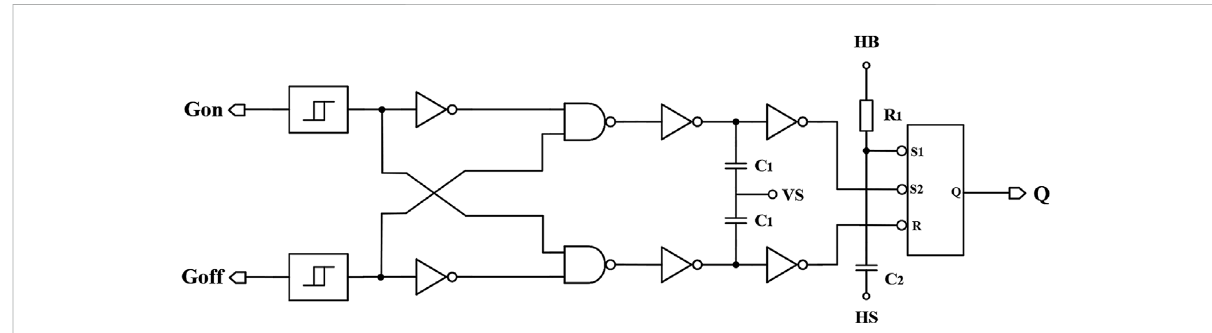
FIGURE 8 Schematic of the pulse fi lter and RS fl ip- fl op circuit.